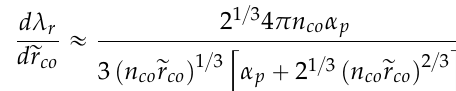
Figure 6. The sensitivity of the bottle resonator temperature sensor as a function of the fiber radius for TE and TM polarizations. r co = 30 μ m, L = 500 μ m, and ∆ r 0 = 3.8 nm . 4. Conclusions We have proposed the use of a bottle resonator as a sensor. We have theoretically analyzed the operation of a bottle resonator with an altitude of several nanometers and with a length of several hundreds of micrometers made on the surface on the fiber with a constant radius, within a range of 10 μ m and 100 μ m. Such bottle resonators can be made with CO 2 laser processing or with 248 nm excimer laser beam ablation with sub-angstrom precision [23]. They can be excited with a tapered fiber placed at the top of the resonator perpendicular to the fiber axis. Like FBG sensors the bottle resonator sensors have all the advantages of the fiber geometry and can be used for refractive index and temperature sensing. Contrary to FBG sensors bottle resonator sensors are immune to decay at high temperature. A bottle resonator made on the fiber surface does not cause coupling of the fiber modes propagating in the core of the fiber, that is bottle resonator sensors can be made on the surface of an active fiber device, such as a high power fiber laser or a laser cooled fiber sample, to monitor the temperature distribution along these devices without any perturbation of device performance. The refractive index bottle resonator sensors have advantages over the SPP sensors, as they are free from metal parts, which introduce undesirable loss in the system. Although the refractive index sensitivity of SPR sensors is higher than the sensitivity of bottle resonator sensors,a bottle resonator sensor with a nanoscale altitude made on the top of the fiber can be easily integrated in any fiber scheme. Acknowledgments: RK would like to acknowledge the Natural Sciences and Engineering Council of Canada’s Discovery Grants program and the Canada Research Chairs programs for financial support..